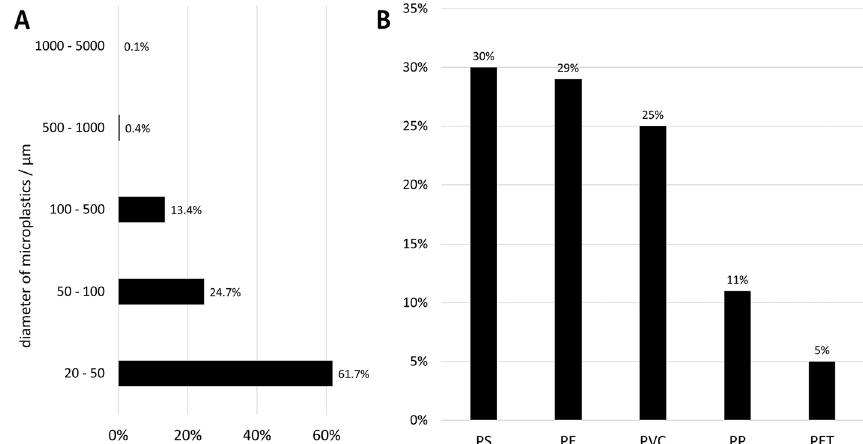
Fig. 3 Size ( A ) and polymer distribution ( B ) of microplastics in the data